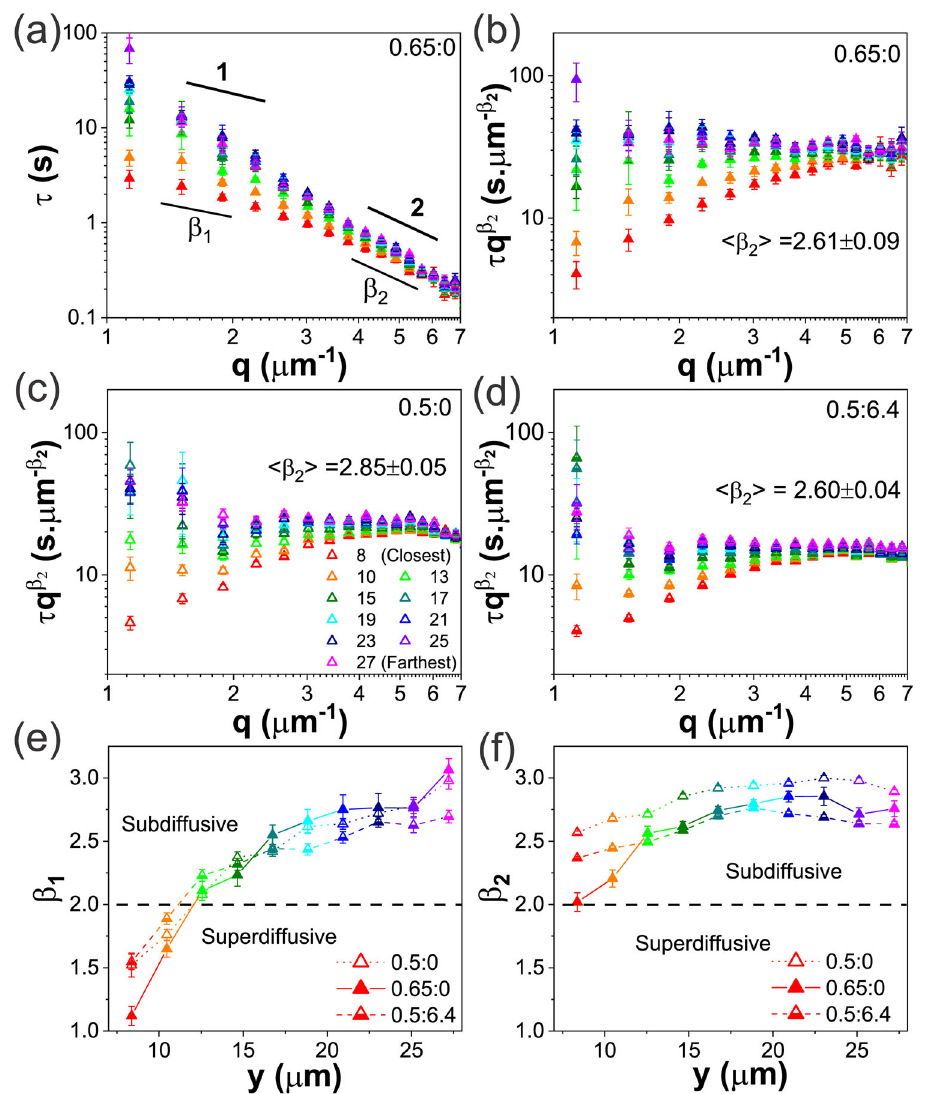
Fig. 3 | DDM decay times reveal universal biphasic DNA dynamics that range contrast, q ≳ q c scaling displays minimal y dependence (data collapse). The cross- from ballistic to subdiffusive. All data is for _ γ =42s − 1 , which induces the most overfrom β 1 to β 2 scalingoccursatalower q c valueof~3.3 μ m − 1 for0.5:0and0.5:6.4 pronouncedalignment(seeFig.2). a DDMdecaytimes τ ð q Þ versuswavevector q for compared with 0.65:0, corresponding to λ c =2 π = q c ≈ 1.9 μ m, comparable to (cid:2) (cid:3) y determined from fi tting τ q < q c d T ≈ 1.7 μ m for the 0.5:0 system. e β 0.65:0 evaluated at varying distances y , represented as warm to cool colors for 1 versus y =8 – 27 μ m (seelegend).Closerto the strain (red,orange), τ ð q Þ curves exhibittwo curves forall three systems plotted in b – d . Dashed line indicates normalBrownian diffusion ð β 1 =2 Þ while β 1 =1 and β 1 >2 indicate ballistic and subdiffusive dynamics, distinctscalingregimesdescribedby τ q ð Þ ~ q (cid:2) β 1 and τ q ð Þ ~ q (cid:2) β 2 forsmallandlarge q values, respectively. Scaling exponents for diffusive ð β =2 Þ and ballistic ð β =1 Þ respectively. 0.65:0 (closed symbols) exhibits the most superdiffusive, nearly bal- dynamics are also shown. τ q ð Þ curves for q ≳ 4 μ m − 1 are largely independent of y , listic motion near the strain (small y ) and most extreme subdiffusion far from the strain (large y ), whereas 0.5:6.4 (half- fi lled symbols) exhibits the weakest y while they diverge for q e ≲ 4 μ m − 1 . The crossover wavevector q c ’ 4 μ m − 1 corre- dependence and the least deviation from normal diffusion. f β 2 versus y , deter- sponds to a lengthscale λ c =2 π = q c ’ 1 : 6 μ m, comparable to the tube diameter (cid:2) (cid:3) d T ’ 1 : 5 μ m for 0.65:0. b – d τ q ð Þ normalized by the corresponding large- q scaling , exhibits minimal y dependence and weakly sub- mined from fi tting τ q > q c q (cid:2) β 2 versus q for b 0.65:0, c 0.5:0, and d 0.5:6.4 subject to _ γ =42s − 1 straining. All diffusive dynamics. Each data point and corresponding error bar shown in a – f represent the mean and standard error across fi ve different systemsexhibitbiphasicscalingbehavior,andstrong y dependencefor q ≲ q c ,with β β β y increases. In 1 varying from < 2 (positive slopes) to > 2 (negative slopes) as